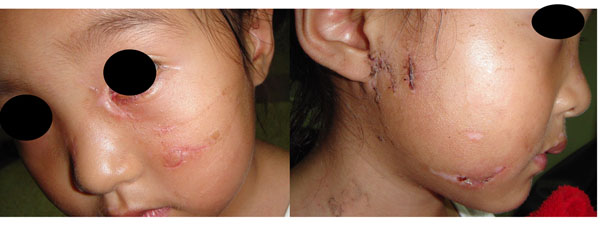
14d after bite. We carried out immediate primary closure and restored the eyelids and parotid gland immediately. The stitches were removed on the 5d, and then reconditioned the nasolacrimal canal.